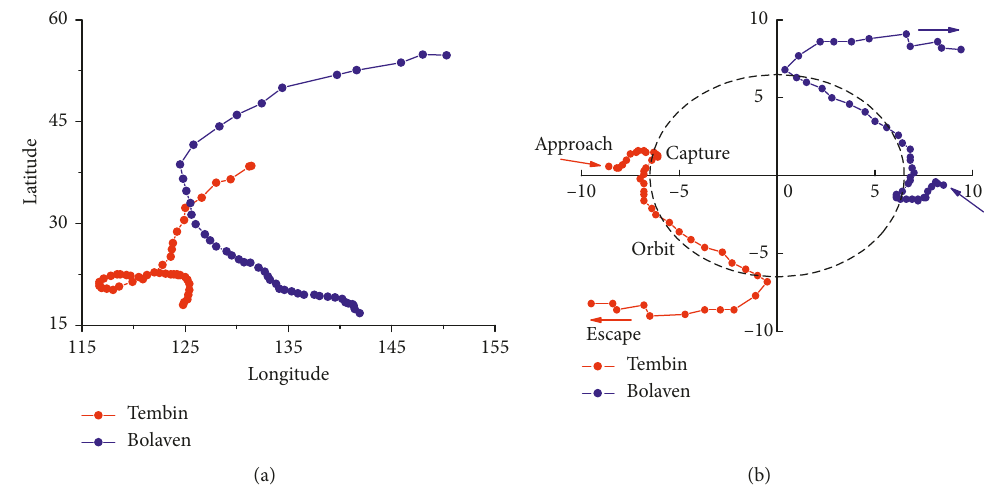
Figure 1: Tracks of Typhoons Tembin and Bolaven (a) and a “Fujiwhara” diagram for the binary interaction between them (b) from 0000 UTC 20 August to 0000 UTC 1 September (interval: 6 hours; red dots: Tembin; blue dots: Bolaven). In (b), distances are in degrees latitude. Dots are centroid-relative positions. The major elements of “Approach”, “Capture”, “Orbit”, and “Escape” are labelled. The radius of dash circle is 6.5 degrees. The origin of coordinate denotes the geographical center between the two